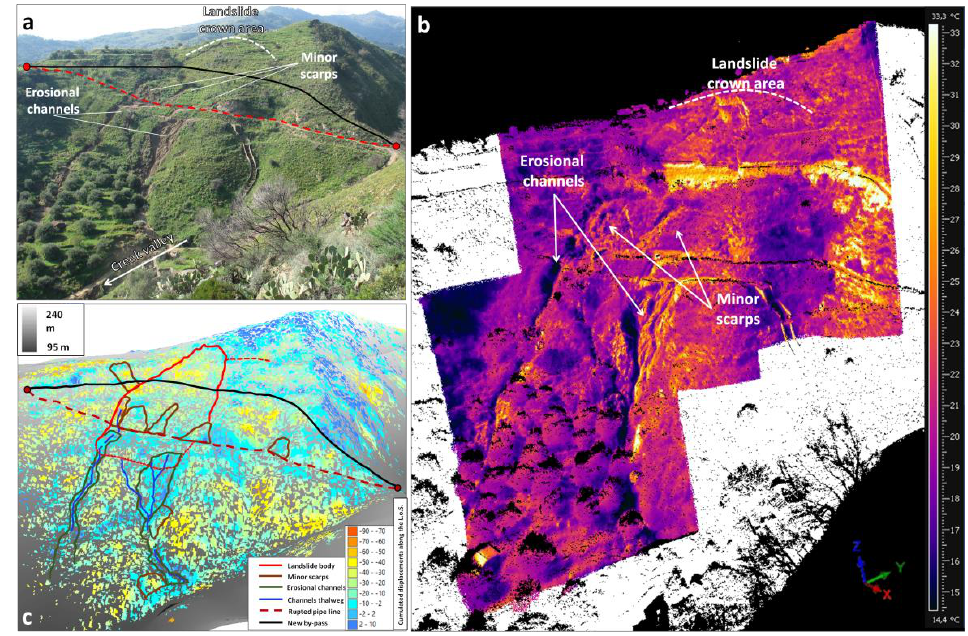
Figure 16. Image of the Calatabiano landslide acquired on 10 November 2015 from the monitoring system installation point ( a ) (the dashed white line represents the main landslide crown, the dashed red line represents the rupted pipeline); 3-D surface temperature map of the landslide area projected on TLS point cloud acquired on 12 November, h 13:00 ( b ); The Calatabiano landslide 3D geomorphological map, projected both on high resolution DEM, obtained by means of the TLS survey, and on GB-InSAR cumulated displacement map ( c ); after [76,77].